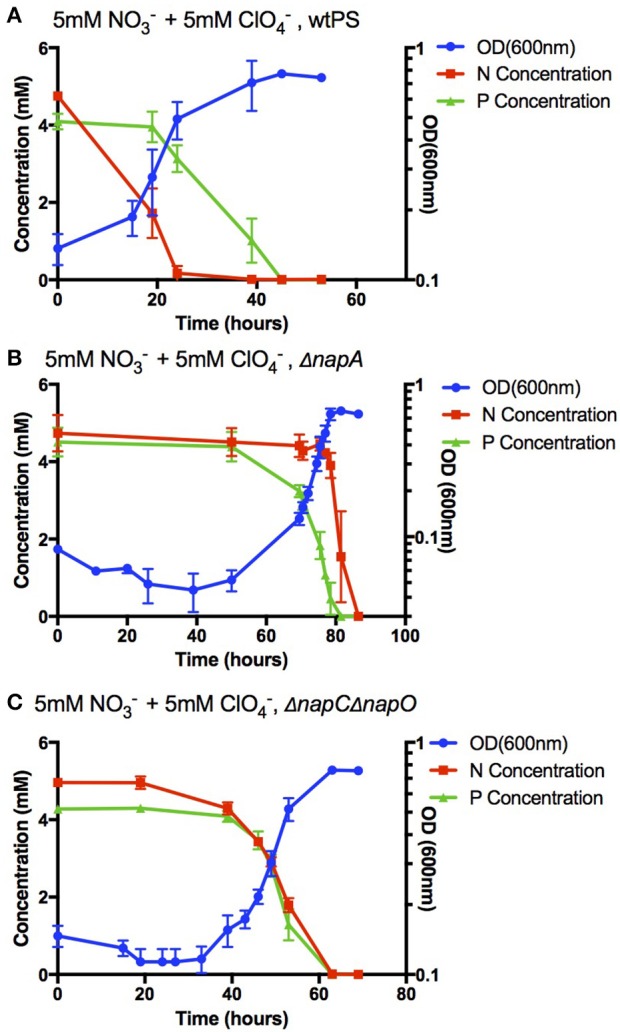
Growth and concentration of nitrate or perchlorate in cultures of wtPS (A), ΔnapA
(B), and ΔnapCΔnapO
(C), in LMM medium with 5 mM nitrate and 5 mM perchlorate. Error bars represent standard deviations of biological triplicate samples.